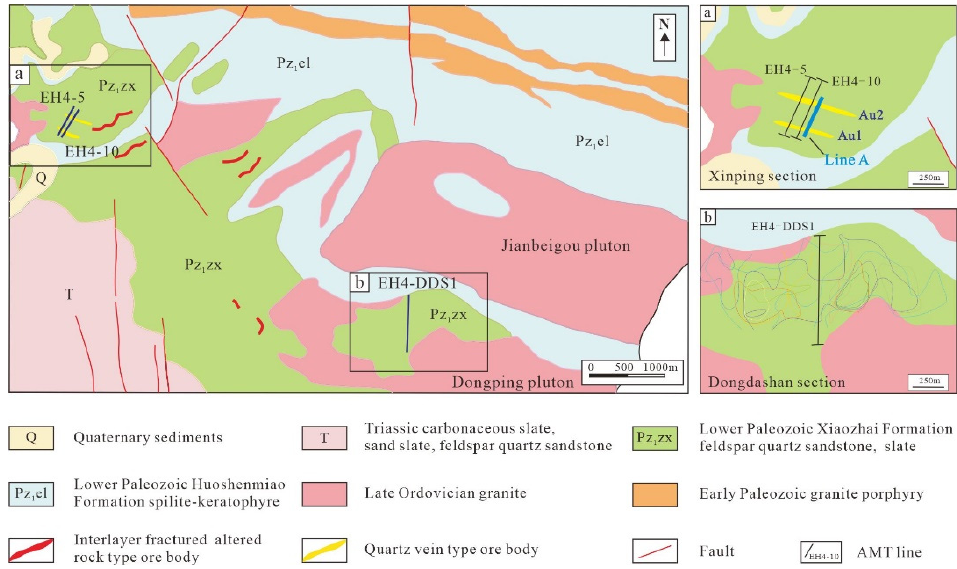
Figure 3. Geological map and the distribution of AMT survey lines in Jianbeigou gold deposit showing: ( a ) Line 10 and Line 5 in Xinping section; ( b ) Line DDS1 in Dongdashan section (Modified [40]).